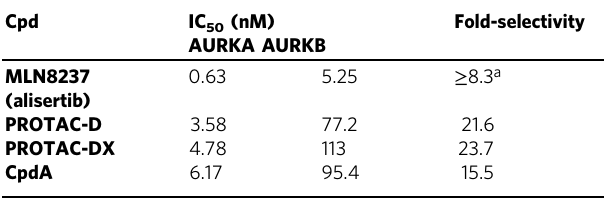
Enzyme inhibition (IC 50 ) of different compounds in in vitro kinase assays. IC 50 s are shown as geometric means of three repeats (MLN8237, PROTAC-D, -DX) or two (Cpd A). Fold- selectivity is expressed as the relative af fi nity for AURKA over AURKB. a Measured IC50 for AURKA is at the lower limit of dose range and below the theoretical tight binding limit of the assay. Therefore true IC50 may be somewhat lower (and fold-selectivity